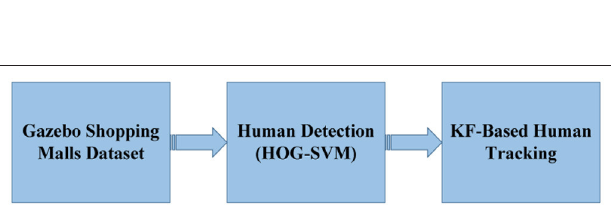
FIGURE 2 | Top view of the designed shopping mall simulation environment including Turtlebot and UAV, and some frames acquired by Turtlebot and UAV (Turtlebot and UAV move independently of each other in the shopping center and perform their tasks through the frames they obtain).